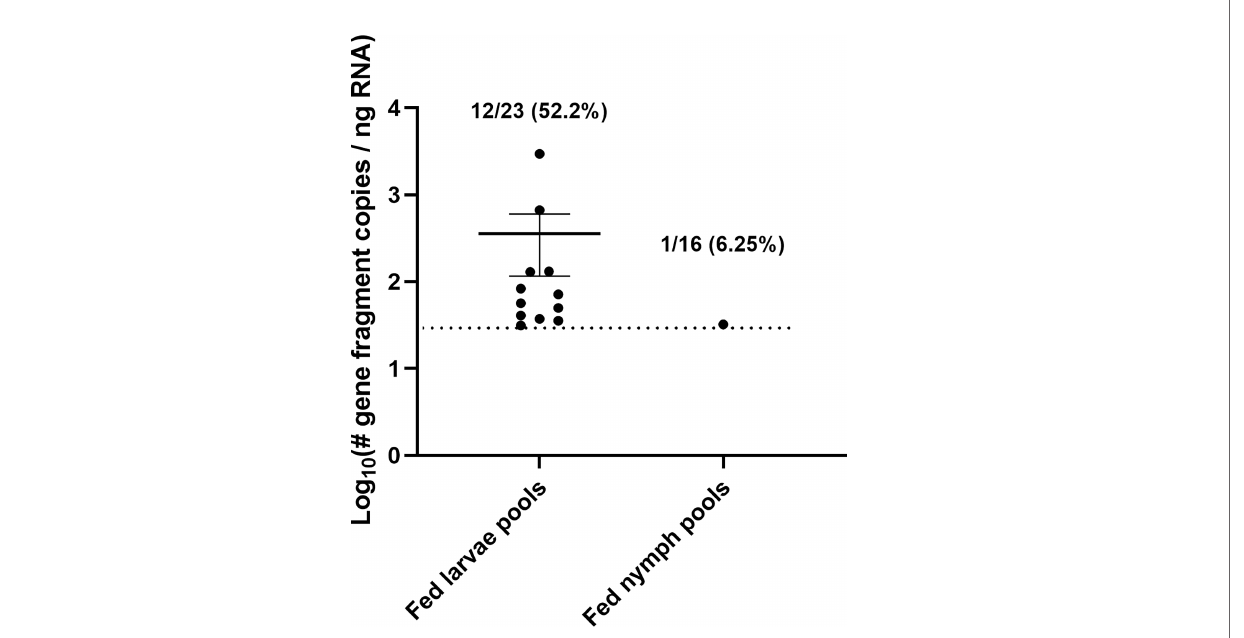
FIGURE 5 | Acquisition of POWV by H. longicornis ticks fed on viremic mice. Detection of POWV RNA in engorged larvae and nymphs that fed on POWV-infected mice. Ticks were pooled at n=5 for larvae and n=3 for nymphs. POWV RNA was detected in pooled fed tick samples via q-RT-PCR. Viral RNA quantities are expressed as the number of NS5 gene fragment copies per ng of RNA after normalization to a standard curve. The data are presented as means with error bars representing standard error of the means. Limit of detection ~31 gene fragment copies per ng